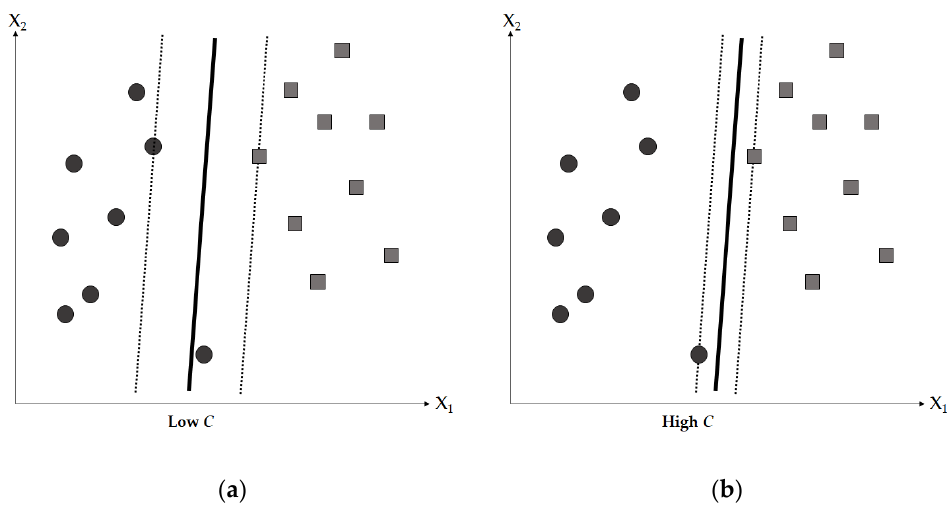
Figure 3. Effect of C on SVM: ( a ) Low C ; ( b ) High C